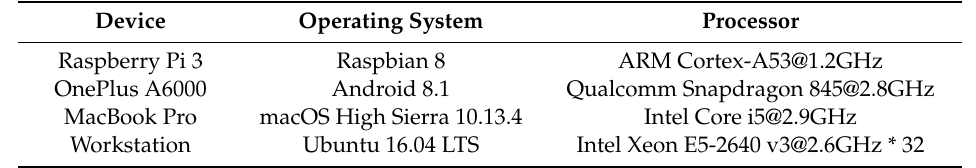
Table 1. Device configurations.